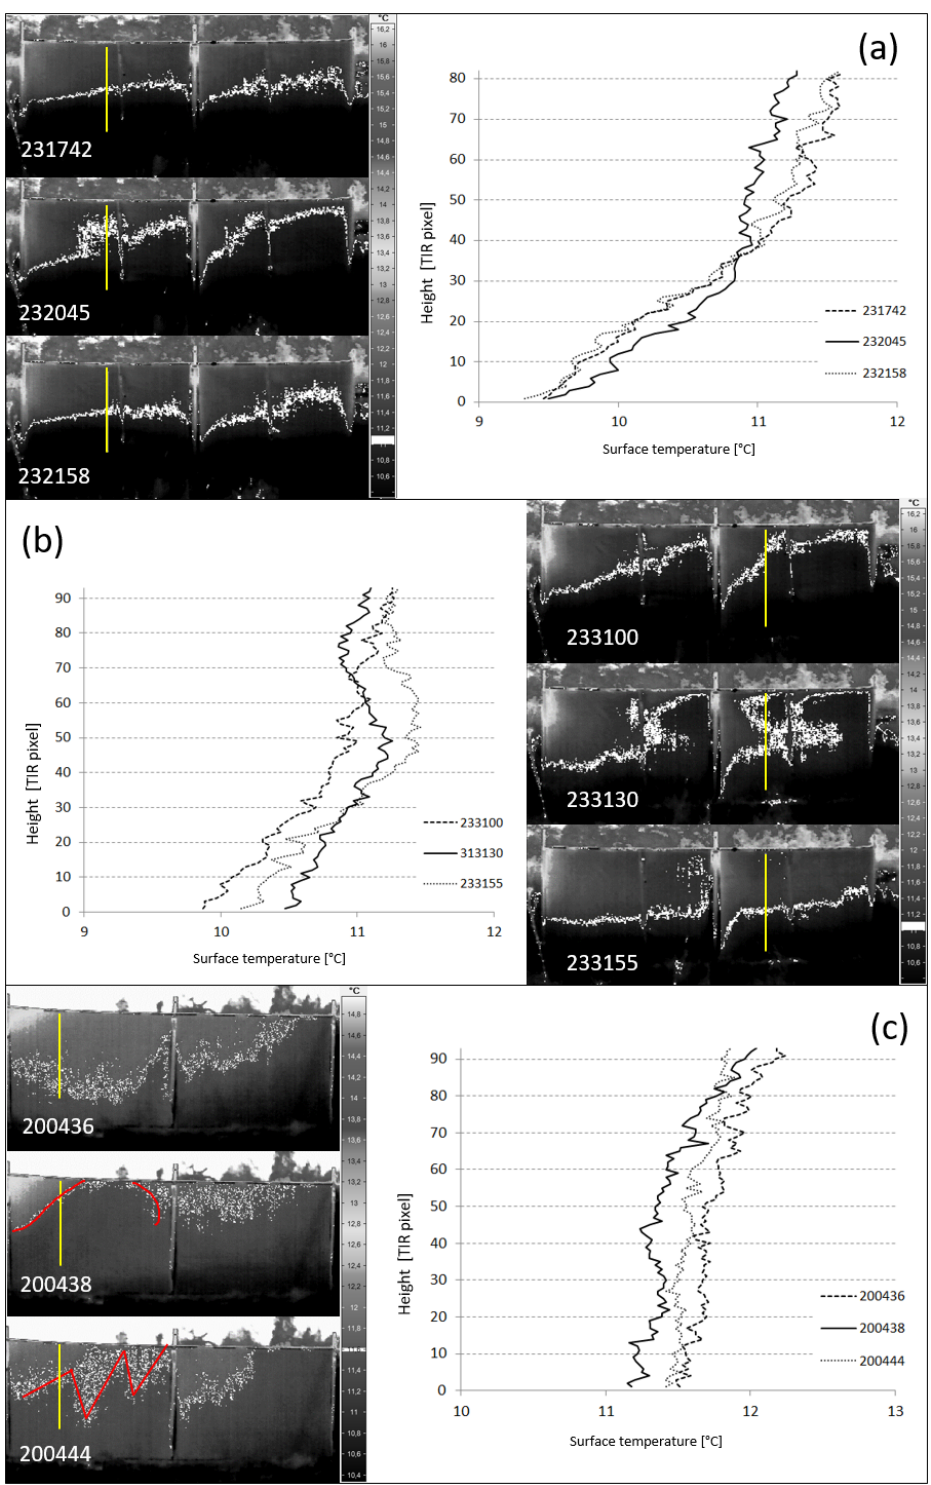
Figure 8. Cold-air pulse transition zones. Three exemplary situations, each with three moments of local time (hour:min:sec): ( a , b ) on 23 July 2012; ( c ) on 22 September 2010, a previous measurement campaign with the same setup and similar clear and calm weather conditions. Yellow line = profile diagram location for graphs with different heights, starting at different heights above ground; red line: micro-front at 20:04:38 LT and detrainment at 20:04:44 LT in ( c ).